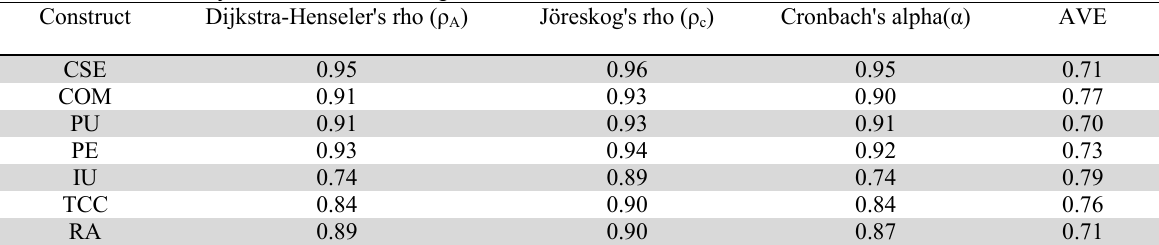
Construct Reliability and Cronbach's